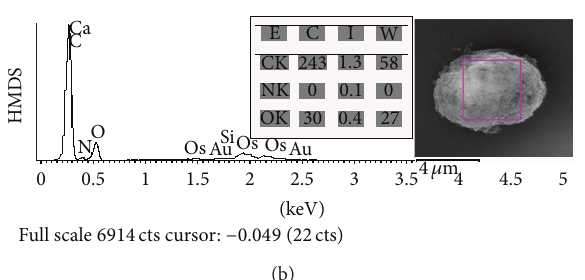
Figure 7: Comparison of mapping elemental analysis for sample preparation based on CPD and HMDS techniques for sample (a) and sample (b), individually. Note: E = element; C = concentration; I = intensity; W = weight; CK = carbon; NK = nitrogen; OK =